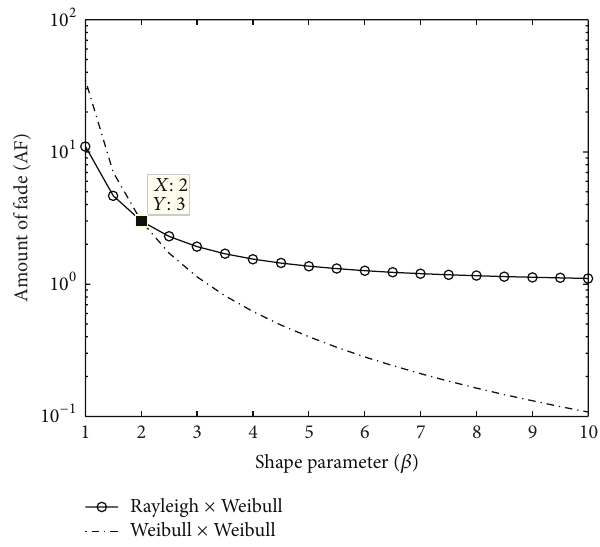
Figure 5: Amount of fade for Rayleigh × Weibull heterogeneous compound